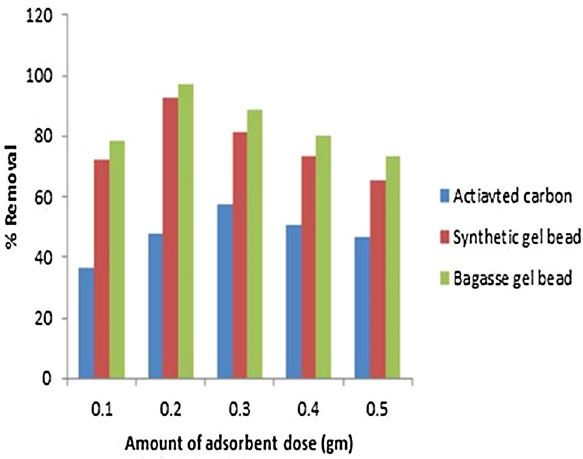
Fig. 4 Effect of adsorbent dose on the adsorption of chromium ions onto bio-polymer beads and activated carbon = 0.2, 0.3 g, pH = 4.6, temperature = 25